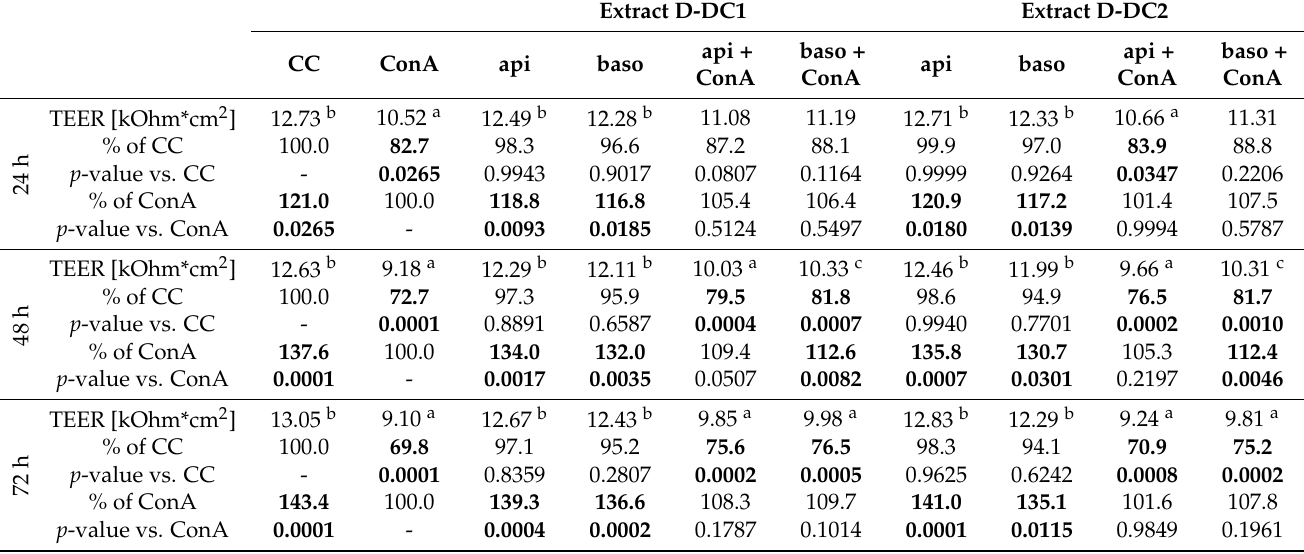
[kOhm*cm 2 ] was observed over a 72 h period. Absolute TEER values are shown compared with the unstimulated CC (solid line). Effects of extracts D-DC1 (on the left) and D-DC2 (on the right) without ConA-stimulation were compared statistically with the unstimulated CC. Effects of the extracts in the presence of ConA-stimulation were compared statistically with the ConA-stimulated control (dashed line, ConA). Bars and error bars represent the means and standard deviations of 4 independent experiments (n = 4). Significant differences are indicated by asterisks ** p < 0.01, T trend, p < 0.1). Table 1. Effects of D-DC1 and D-DC2 extracts (applied at 150 µ g/mL) on the co-culture model of the piglet gut. TEER [kOhm*cm 2 ] was observed over a 72 h period following stimulation and relative TEER values were calculated compared with the unstimulated CC and the ConA stimulation control. Effects of treatments were compared with both stimulated ConA and unstimulated CC groups for apical (=api) and basolateral (=baso) addition. Relative changes compared with the ConA control are indicated for extract plus ConA treatment groups. Values represent the means of 4 independent experiments (n = 4), as visualized in Figure 2. Statistically significant results, based on absolute TEER values, are indicated by a superscript ( a significant difference compared with CC, p < 0.05; b significant difference compared with ConA, p < 0.05; c significant difference compared with both control groups, p < 0.05), and p -values indicated for comparisons with both CC and ConA. A bold script is used to indicate statistical significance compared with the respective control used for the calculation of the relative TEER value in %. Results for statistical analysis of variation and interactions of row and column factors are included below.